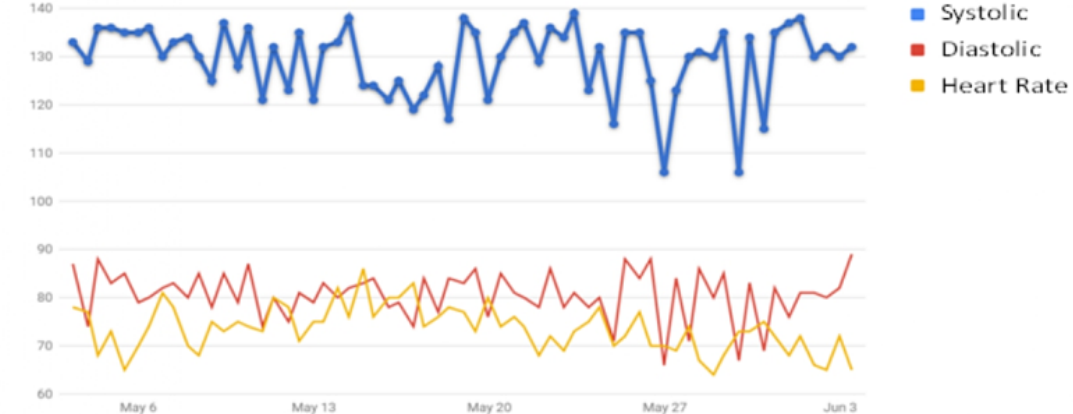
Figure 3. Screenshot of curve diagram on blood